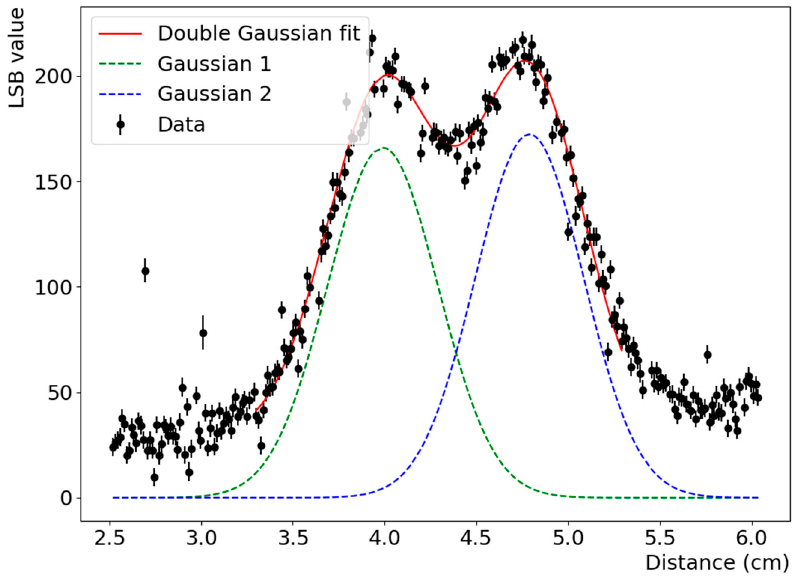
Figure 8. The line-average response profile of the 5 mm diameter holes spaced by 3 mm (edge to edge). The FWHM obtained by the Gaussian distribution is 7.10 ± 0.30 mm for the left hole and 6.80 ± 0.20 mm for the right hole. The distance (center-to-center fit) = 7.98 ± 0.23 mm was obtained by fitting the profile by a double Gaussian function.